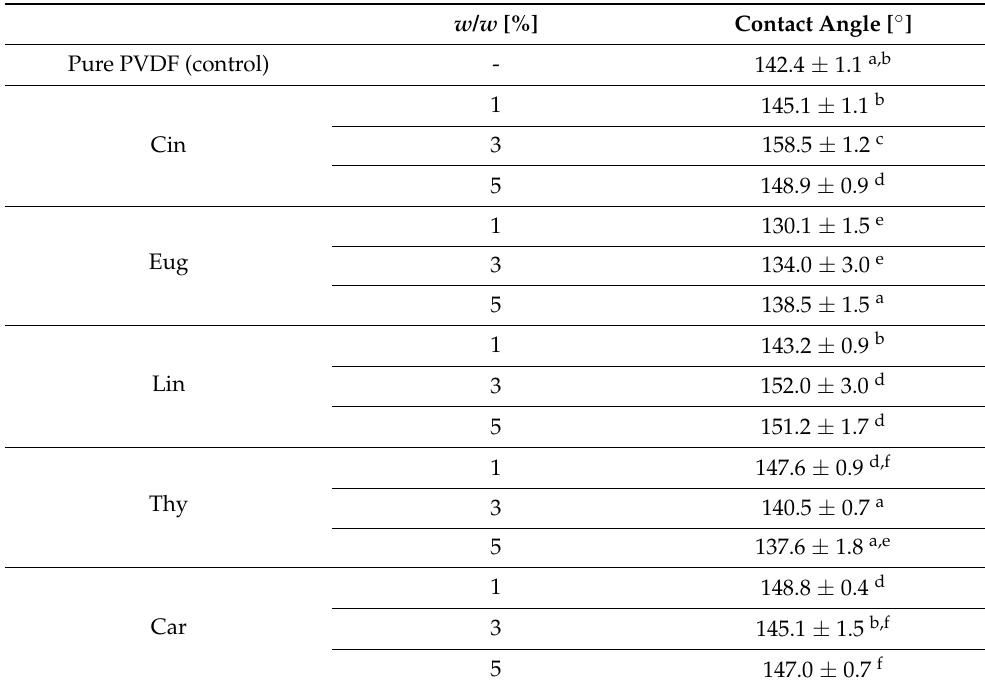
Table 4. Contact angle values of PVDF